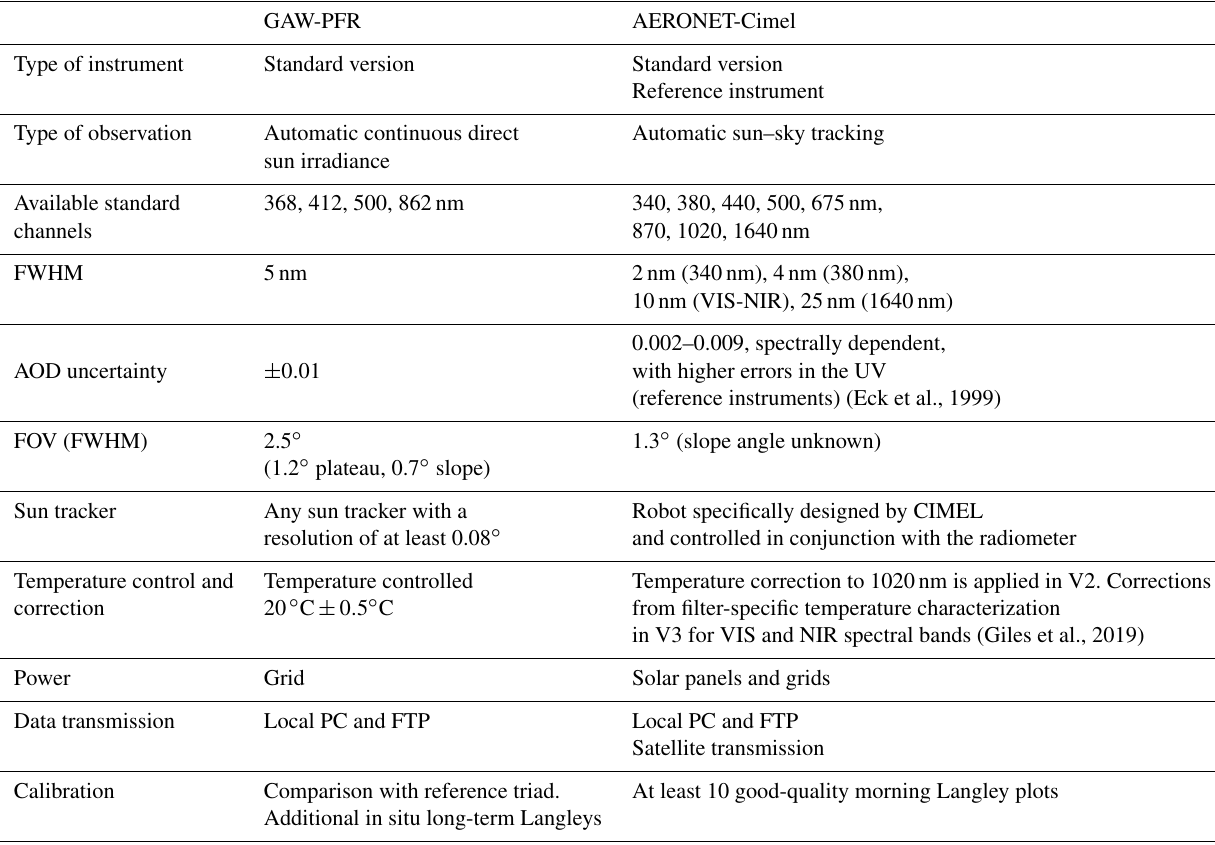
Table 1. Main features of the GAW-PFR (PFR; Wehrli, 2000, 2005, 2008a, b) and AERONET-Cimel (Holben et al., 1994, 1998; Torres et al., 2013) radiometers used in this study.